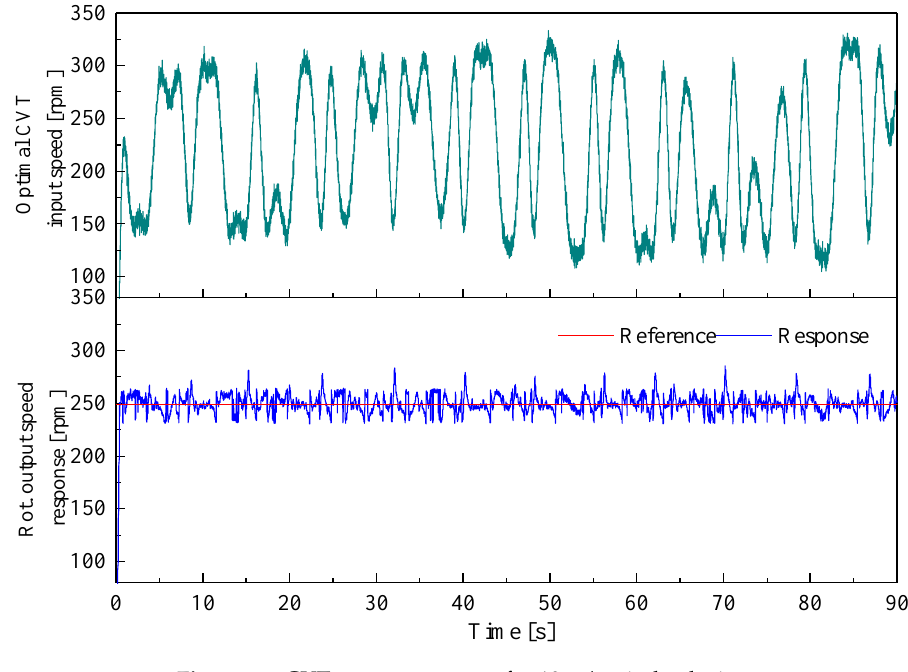
Figure 12. CVT system response for 10 m/s wind velocity.